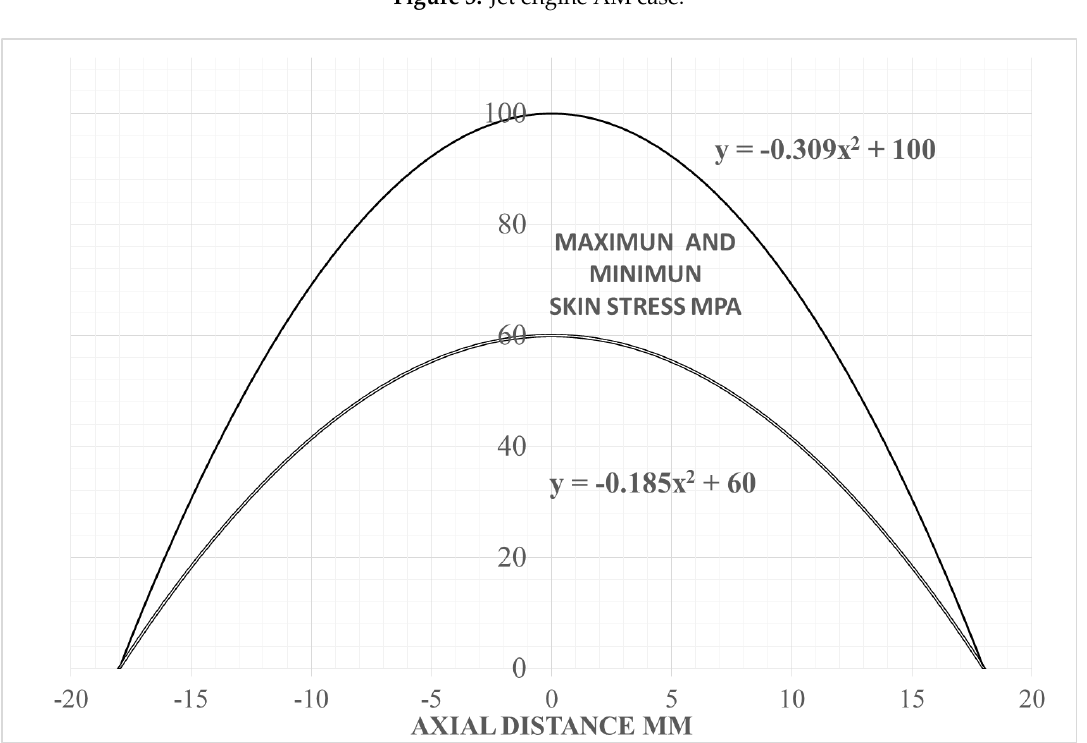
Figure 4. AM cylindrical case circumferential skin stress distribution MPa.